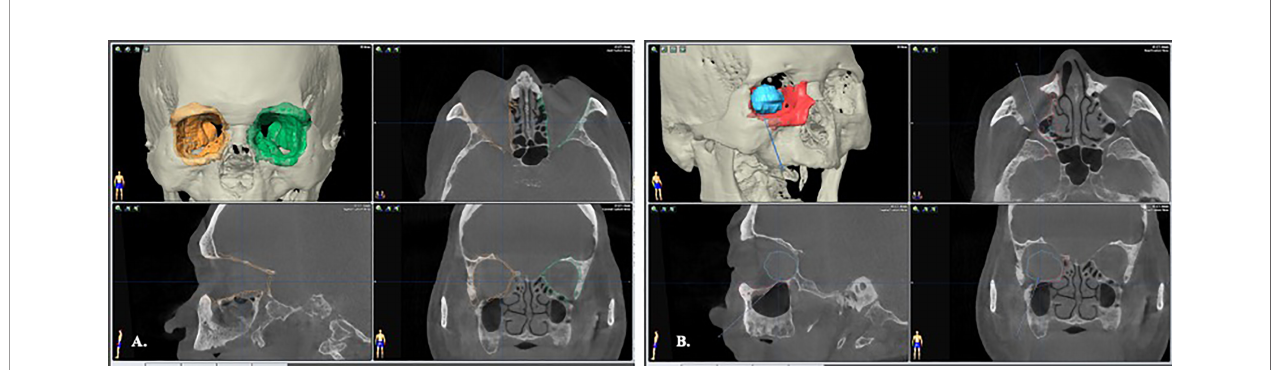
FIGURE 1 | Image segmentation by bone-speci fi c Houns fi eld units. (A) segmentation of the normal, non-destructive orbital wall (green); the mirrored image from the contralateral normal orbital wall to rebuild the destructed right side medio-inferior orbital walls (orange). (B) The orbital tumor was segmented with fusion MRI and CT images to optimize the tumor boundaries (blue). A trajectory through the maxillary sinus that indicated the path of entry to orbital tumor was designed for intraoperative